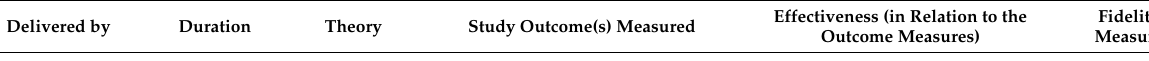
Table 3. Intervention